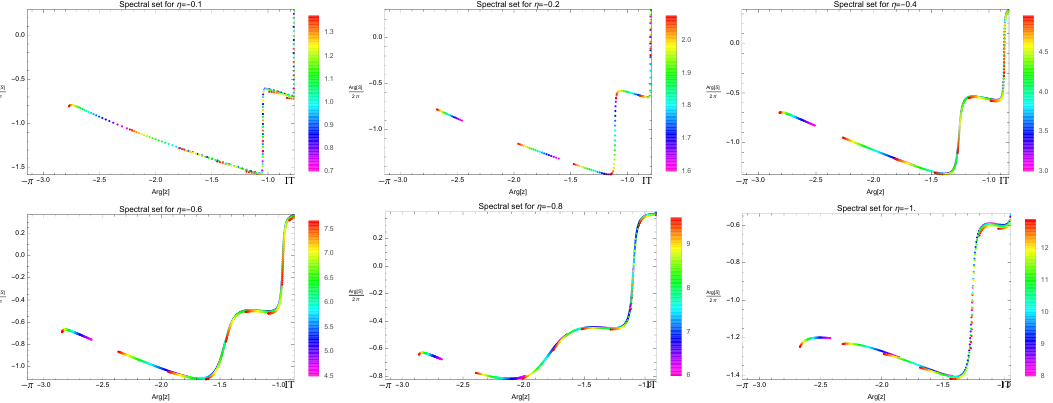
Figure 16. Left: m 4 /m 1 as a function of η , where m 4 is the real part of the energy of the z 0 √ resonance. The red dots represents Re s/m 1 , where s is the locations of the complex resonance z 0 on the s -plane. The black dashed line is the first order result of form factor perturbation theory 4 around the E 8 point η = 0 . Right: Γ 4 / (2 m 1 ) as a function of m 4 /m 1 , where the width Γ 4 is twice the imaginary part of the energy of the z 0 resonance. The crosses represent the locations of 4 √ s/m 1 on the complex plane for the z 0 resonance (equivalent to those in the z -disc plot in left of 4 figure 15). The black dashed curve represents the leading order perturbation theory result [11, 12] (where Γ 4 / (2 m 1 ) is computed to order η 2 , and m 4 /m 1 to order η , near η = 0 ). .